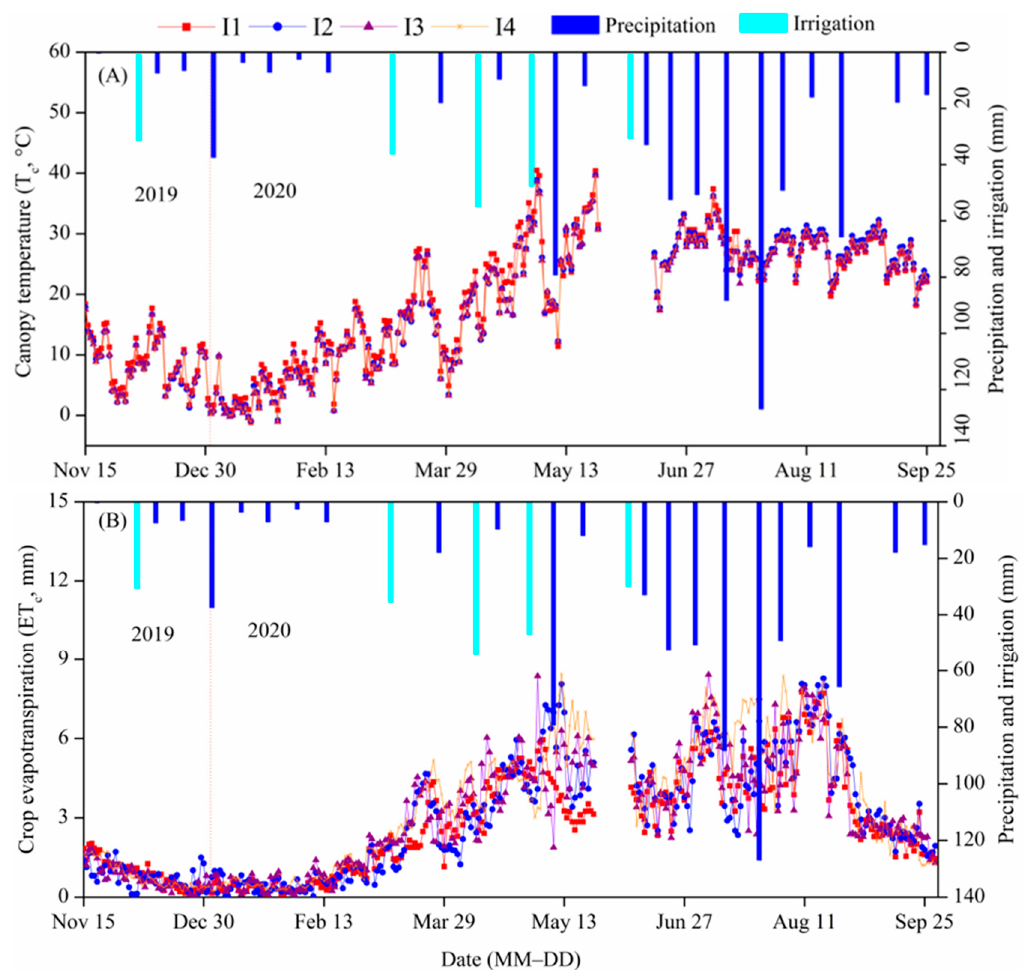
Figure 5. Seasonal variations in ( A ) canopy temperature (T c , °C) and ( B ) crop evapotranspiration (ET c , mm) in a winter wheat–summer maize cropping system in the 2019–2020 growing season. Precipitation is presented as ten-day cumulative values. Irrigation is average values among I1, I2, I3, and I4 treatments.